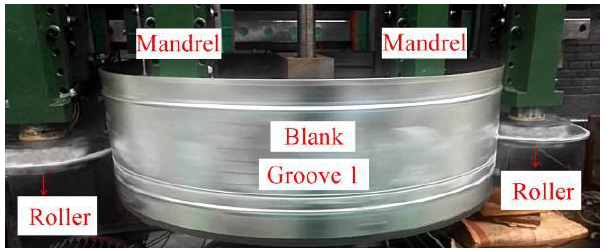
Figure 3. Experiment during Groove 1 spinning.